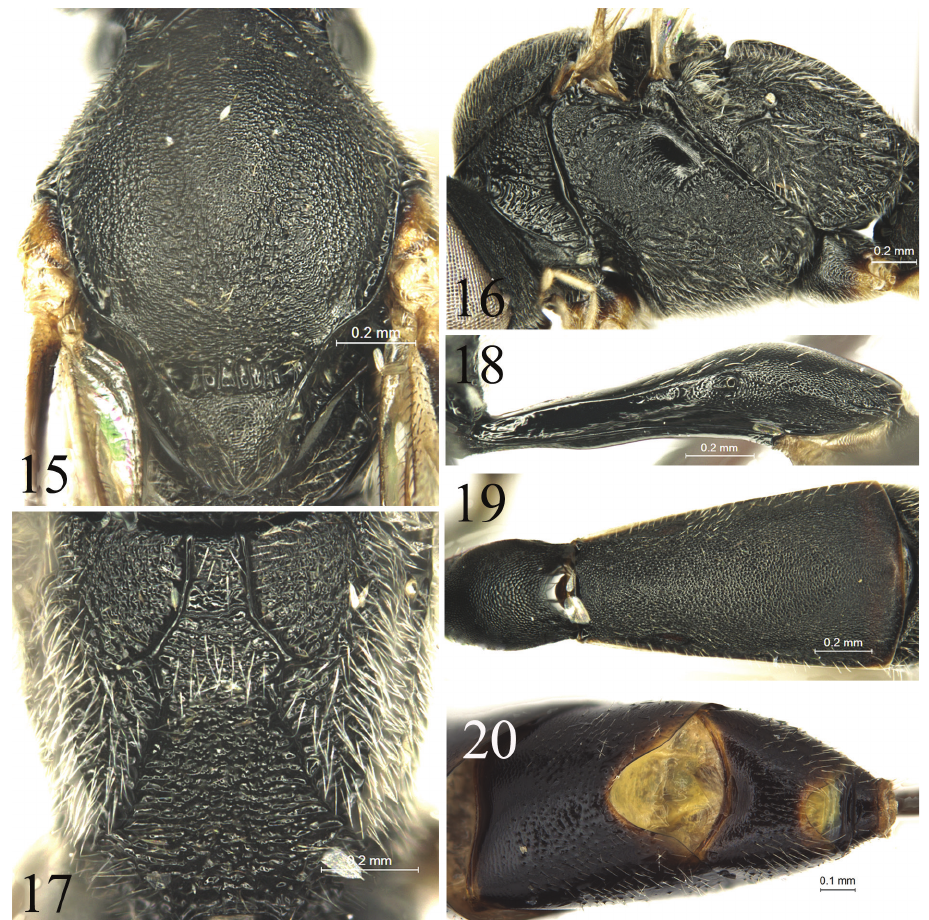
Figures 15–20. Cymodusa melana Sheng, Li & Sun, sp. nov. Holotype. Female 15 mesoscutum and scutellum, dorsal view 16 mesosoma, lateral view 17 propodeum, dorsal view 18 first tergite, lateral view 19 postpetiole and tergite 2, dorsal view 20 (Paratype) Posterior portion of metasoma, dorsal